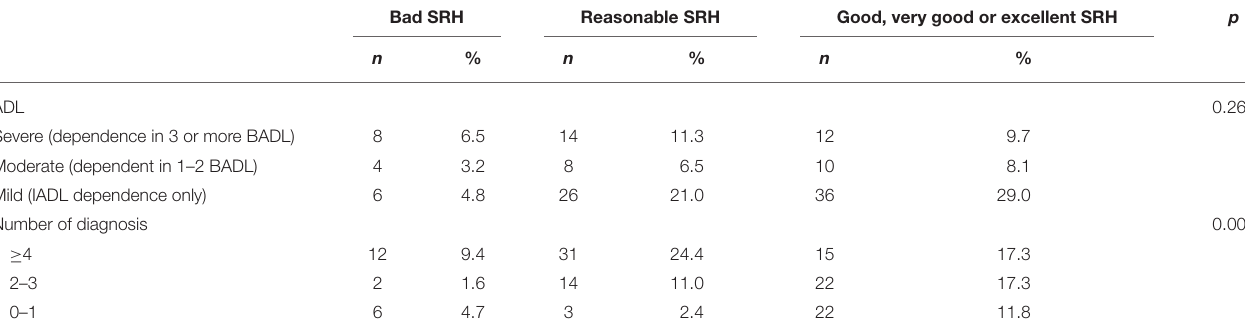
TABLE 4 | Association between SRH and objective health measures (categorical variables).